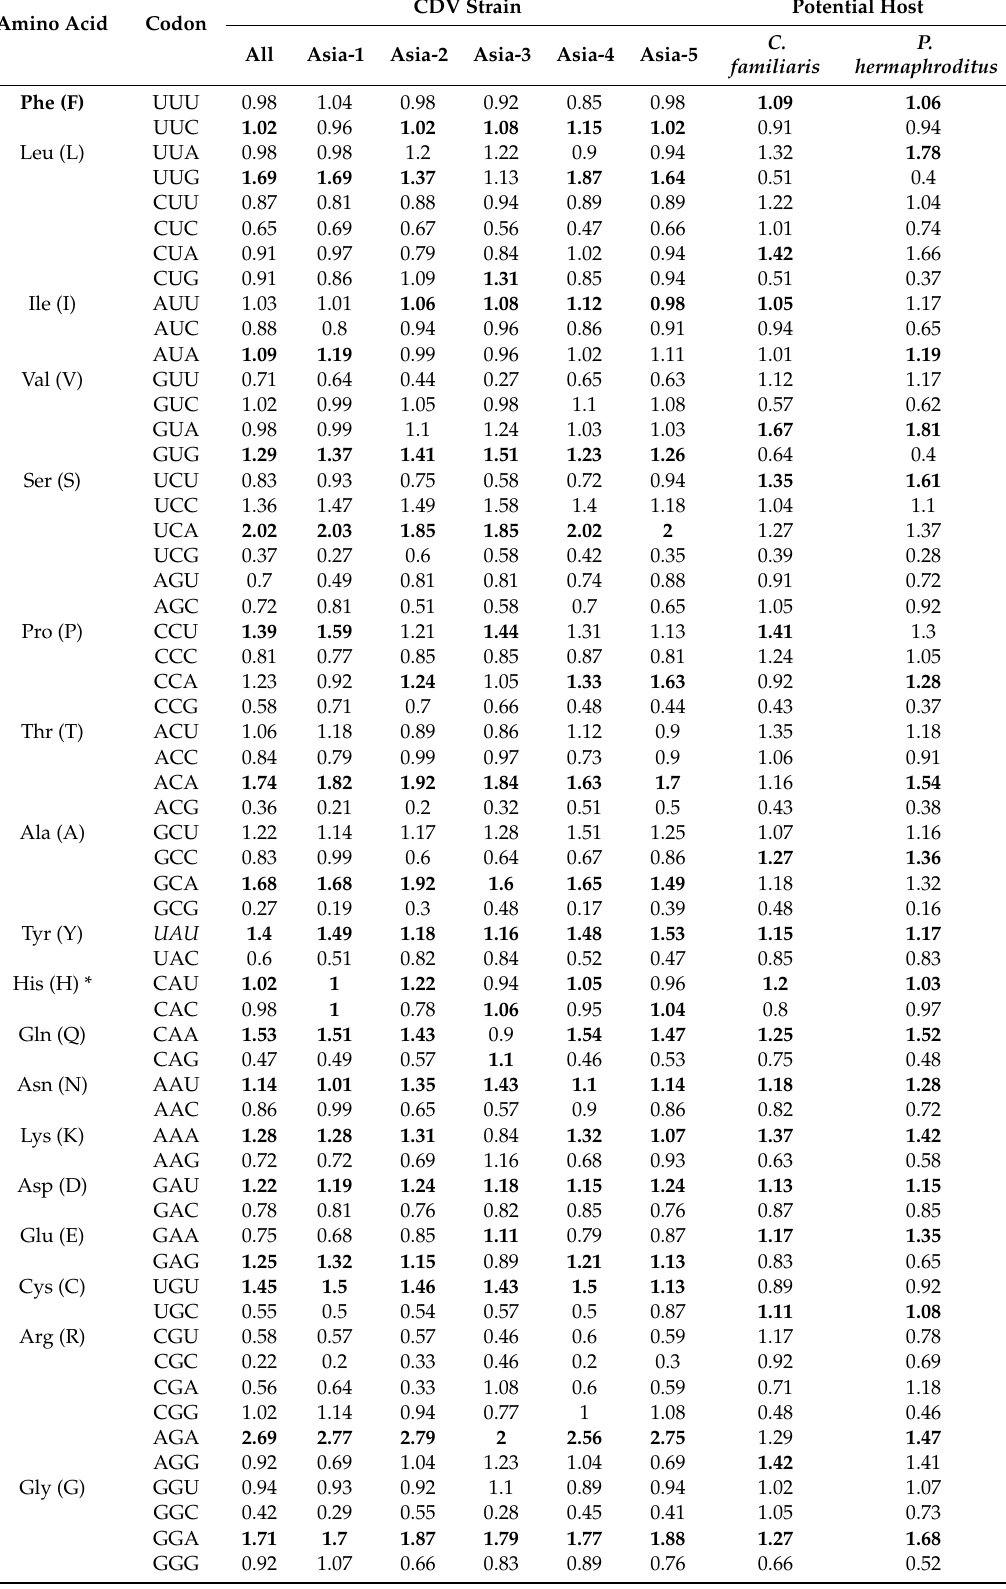
Table 1. The RSCU of CDV Asian strains and their potential